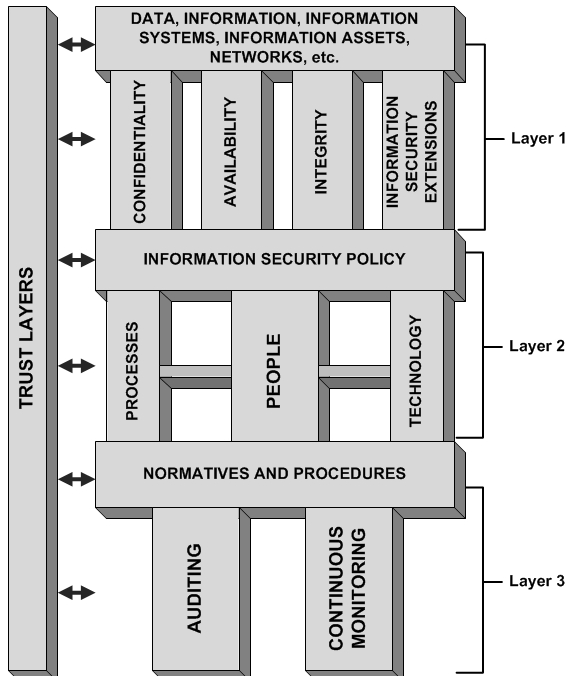
Figure 1. TISA: Layered trust information security